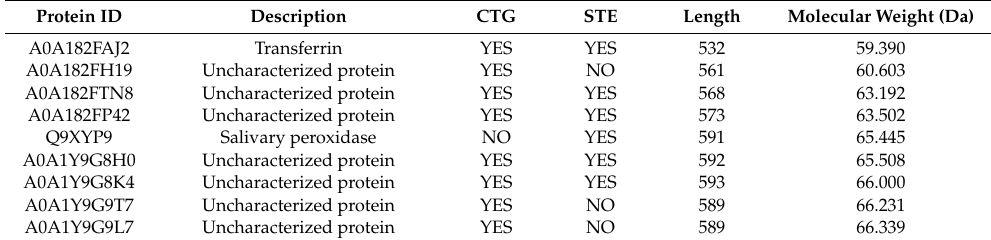
Table 1. List of proteins found by mass spectrometry in a ~65 kDa protein excised from both An. albimanus strains (CTG and STE).